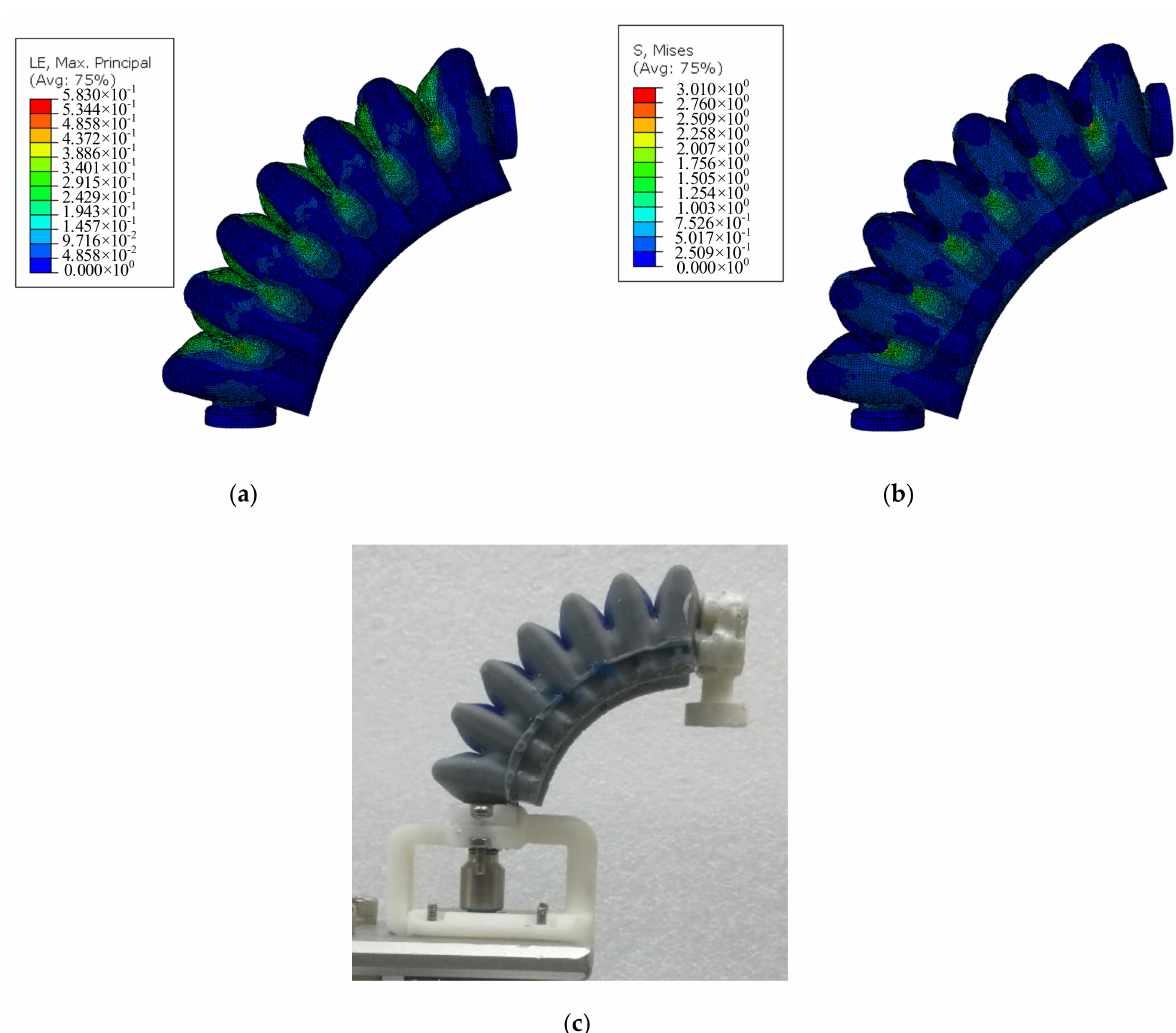
Figure 10. Experimental actuator bending and simulated bending. The hardness composition of the actuator is “58-50-58” and pneumatic pressure is 60kPa: ( a ) Simulation results that show the distribution of strain. ( b ) Simulation results that show the distribution of stress. ( c ) Actual bending of the